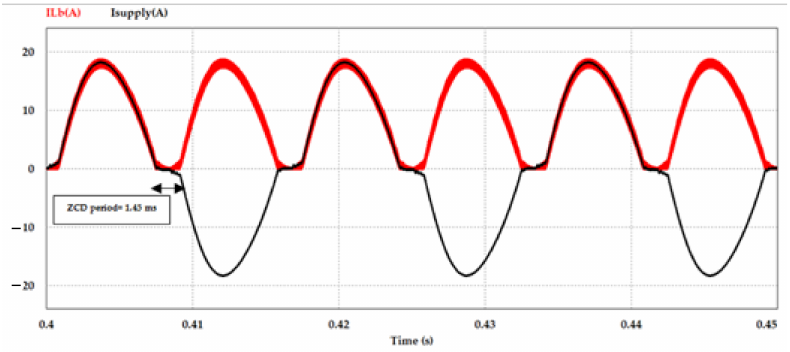
Figure 25. Waveforms of the inductor and supply currents with the PI current controller.